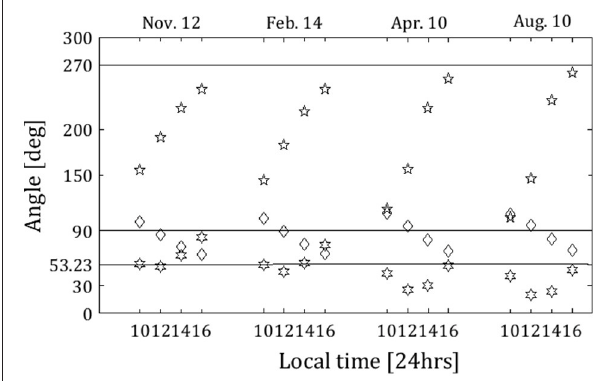
FIGURE 5 | Solar zenith angle (squares), solar azimuth angle (stars), and the sun-horizon (as viewed from the caves)-viewer angle (diamonds), for all times of the polarization measurements. The solid horizontal lines indicate the angle of 270 ◦ , which is the direction of the cave opening, the angle of 90 ◦ , at which the DoLP due to Rayleigh scattering is maximum, and the angle of 53.23 ◦ , at which the solar zenith angle equals Brewster’s angle for an air-water interface.